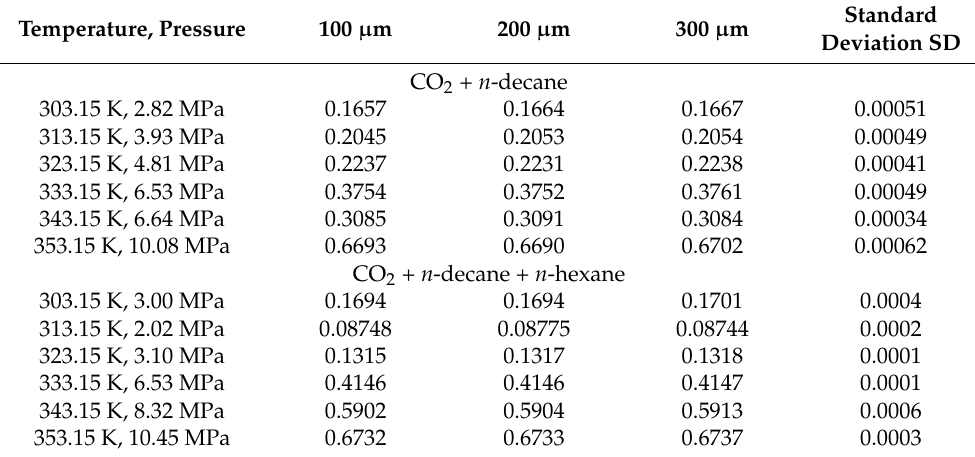
Table 2. The Raman peak intensity ratios of mixture at three positions at different temperatures and